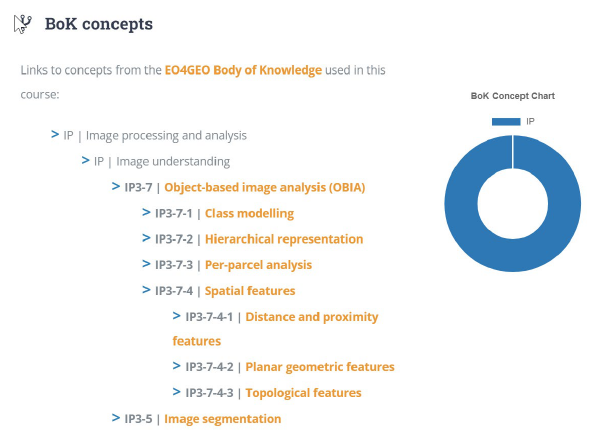
Figure 10 . BoK concepts representing the subjects associated with the training material on Decision Trees. The BoK Concept Chart indicates the major domain to which the associated concepts belong (IP = Image Processing and